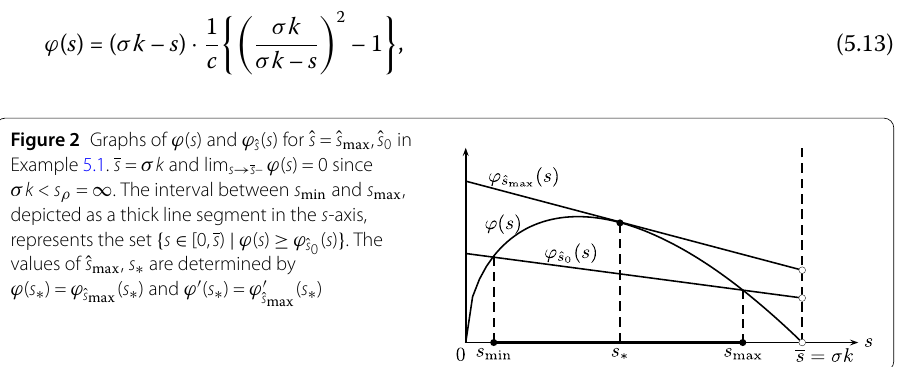
Figure 2 Graphs of ϕ ( s ) and ϕ ˆ s ( s ) for ˆ s = ˆ s max , ˆ s 0 in Example 5.1. s = σ k and lim s → s – ϕ ( s ) = 0 since σ k < s ρ = ∞ . The interval between s min and s max , depicted as a thick line segment in the s -axis, ( s ) } . The represents the set { s ∈ [0, s ) | ϕ ( s ) ≥ ϕ ˆ s 0 values of ˆ s max , s ∗ are determined by ϕ ( s ∗ ) = ϕ ˆ s ( s ∗ ) and ϕ (cid:6) ( s ∗ ) = ϕ (cid:6) ˆ ( s ∗ max s max